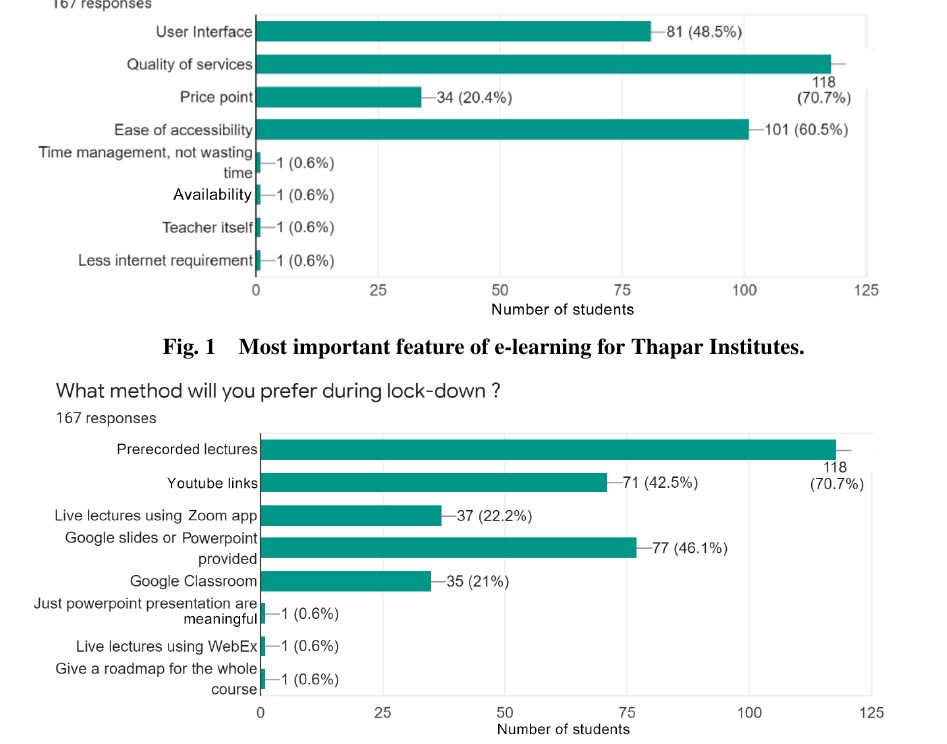
Fig. 2 Mode of preference for learning during COVID-19